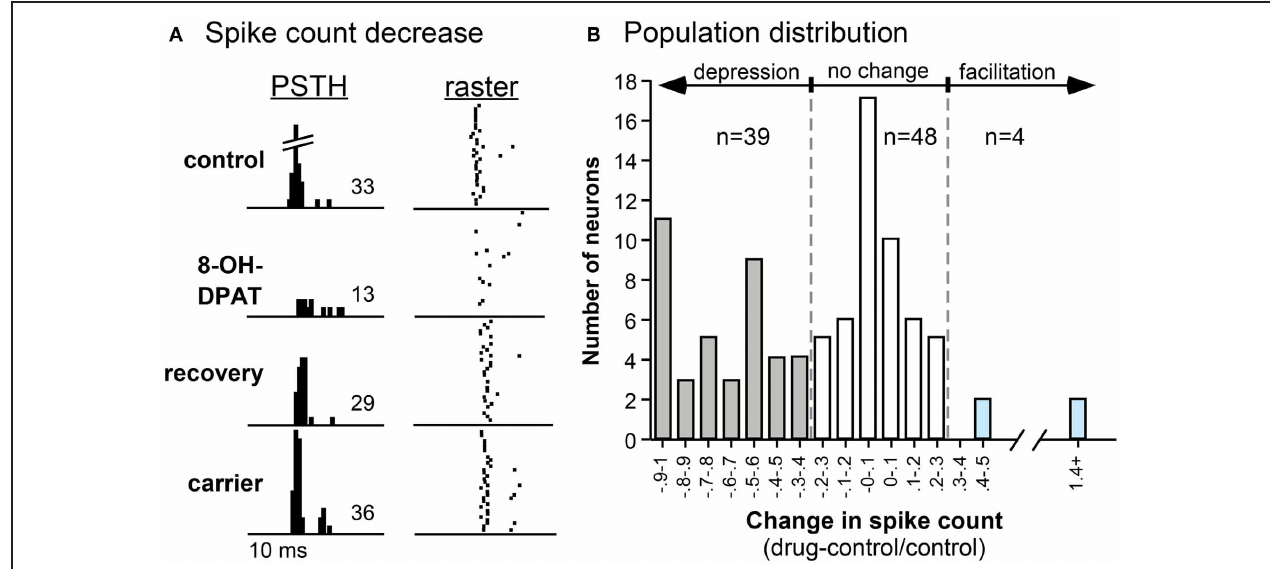
FIGURE 5 | Effects of the selective 5-HT1A agonist 8-OH-DPAT on a single neuron (A) and on a population of IC neurons (B). (A) PSTH and raster plots of the response of a neuron to an FM sweep in the control, during iontophoresis of 8-OH-DPAT, during the recovery, and during the iontophoresis of the carrier solution. The stimulus was a 30-dB SPL, 10-kHz FM sweep centered at 25kHz. (B) Histogram of changes in spike count